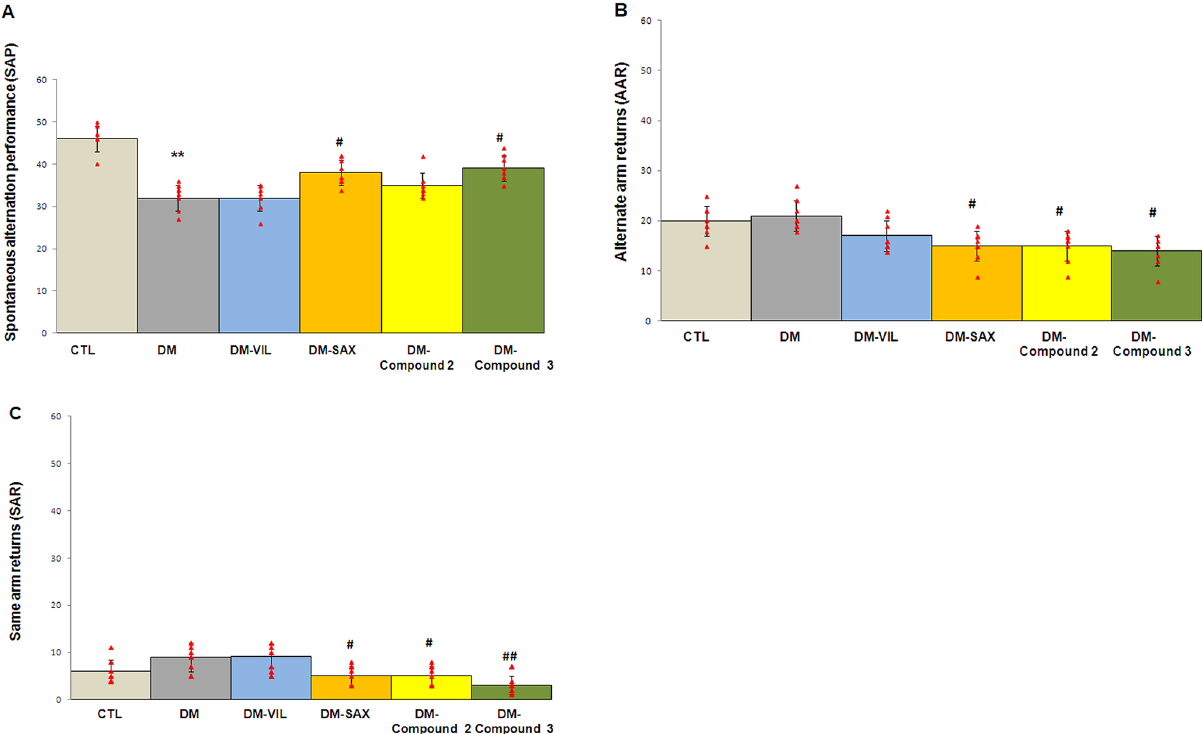
Figure 2. Novel adamantane derivatives ( 2 , 3 ) and DPP4 inhibitors ameliorate the working spatial memory impairment of diabetic mice in Y-maze test. ( A ) The spontaneous alteration performance (SAP) was defined as visit of animal in three different arms consecutively (i.e. ABC, ACB, BCA, BAC); ( B ) alternate arm returns (AAR) was defined as visit of mouse in the other arms and return to the same arms (i.e. ABA, ACA, BAB); ( C ) same arm returns (SAR) was defined as visit of mouse the same arm repeatedly (i.e. AA, BB, CC); The frequency of the behaviors: spontaneous alternation performance (SAP), alternate arm returns (AAR) and same arm returns (SAR) in all groups was counted and is presented as means ± SD (n = 8). One-way ANOVA, followed by Tukey’s post hoc test was used. Bars in figure illustrate experimental groups— CTL non-diabetic mice, DM diabetic mice, DM‑Vil vildagliptin-treated mice [20 mg/kg, po ], DM‑Sax saxagliptin-treated mice [10 mg/kg, po ), DM‑compound 2 compound 2-treated mice [50 mg/kg, po ], DM‑compound 3 compound 3-treated mice [50 mg/kg, po ], respectively. **p < 0.01 as compared with healthy control group. # p < 0.05; ## p < 0.01 compared with diabetic mice